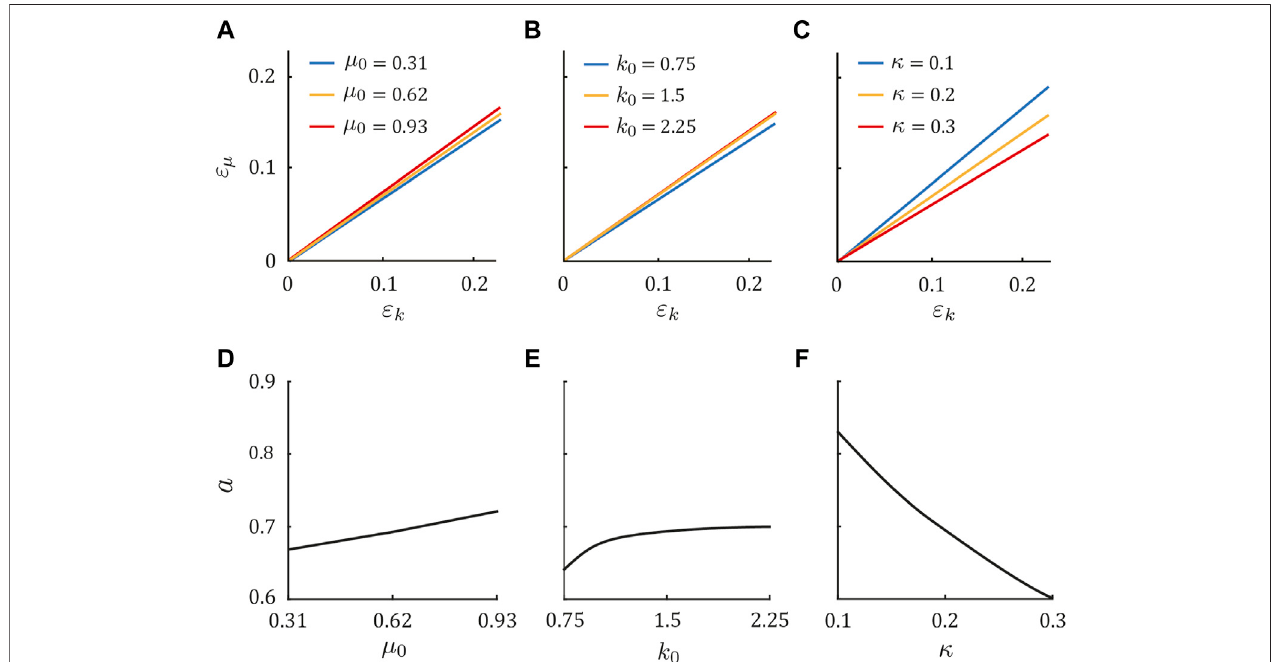
FIGURE4| Gaitdependenceonphysicalparametersinthedogmodel.Conditionof ε k and ε μ ( ε μ = a ε k )toachieve Sequence1forthreevaluesof (A) μ 0 , (B) k 0 ,and (C) κ ,whileholdingtheotherparametersconstantat μ 0 =0.62, k 0 =1.5,and κ =0.2.Sequences5and9appeared when ε μ < a ε k and ε μ > a ε k ,respectively.Dependence of a on (D) μ 0 , (E) k 0 , and (F) κ .